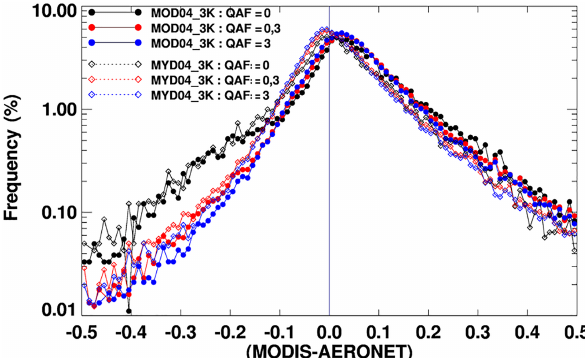
Figure 3. Global distribution of mean bias in MODIS 3km AOD retrievals with respect to collocated AERONET observations. The circular dots with solid lines are for Terra values and diamond dots with dotted lines are for Aqua values. The colors vary for the three quality levels (QAF = 0, poor quality; QAF = 3, high quality; and QAF = 0 and 3, all